Question: Write a single sentence explaining what this figure depicts.
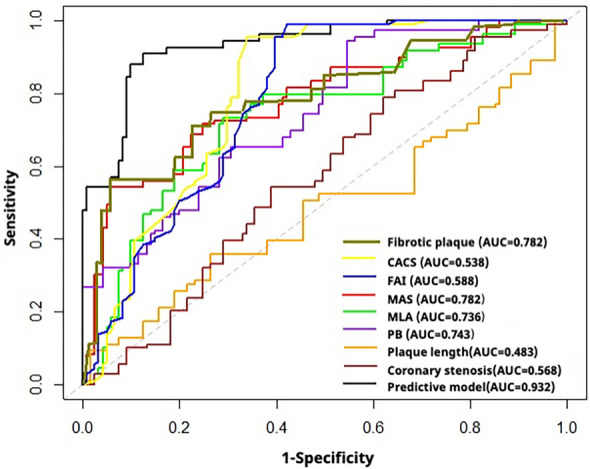
Answer: ROC curves of individual predictors and the combined prediction model for MACE in the external validation cohort.